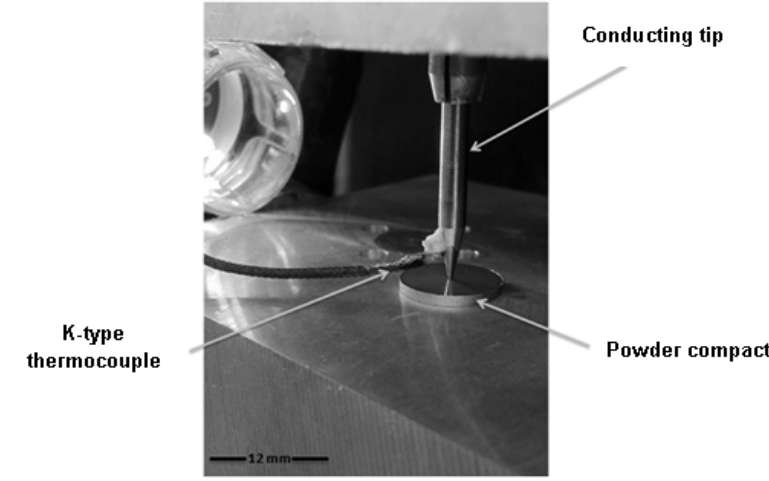
Figure 4. Flat-tip fast-response K-type thermocouple cemented on CATS